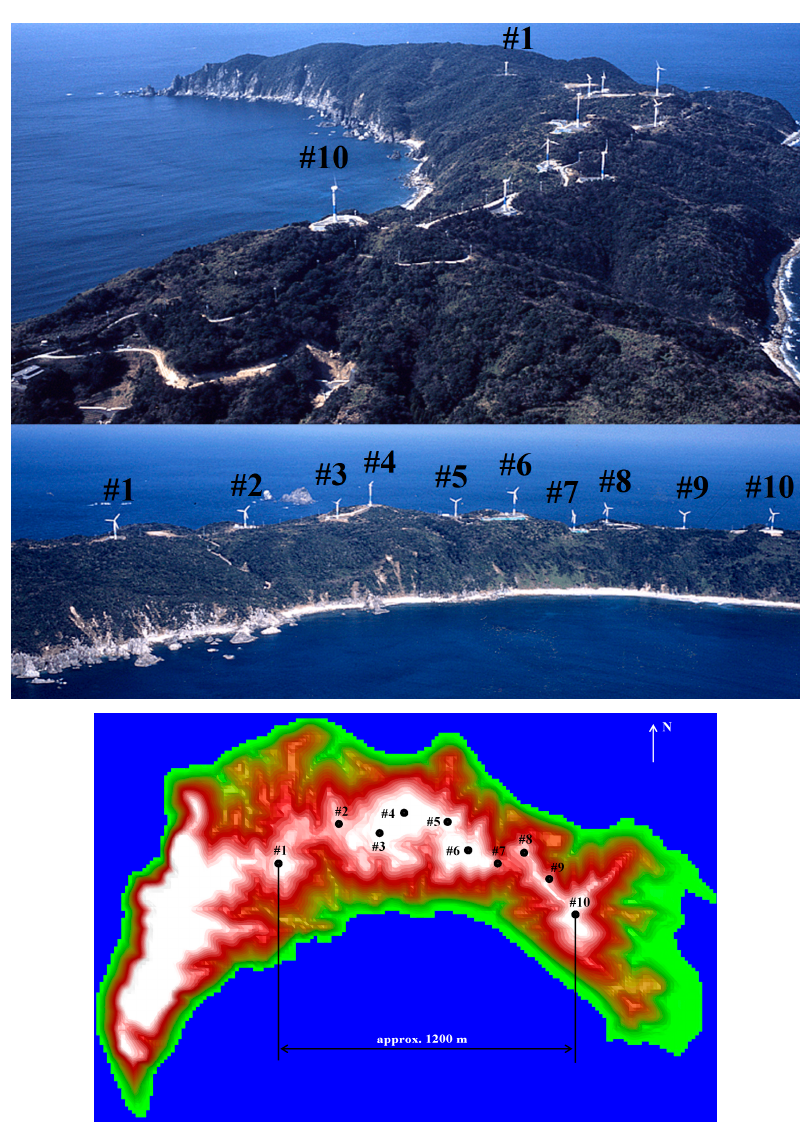
Figure 2. View of Noma Wind Park. Table 1. Specifications of wind turbines (WTs) at Noma Wind Park.